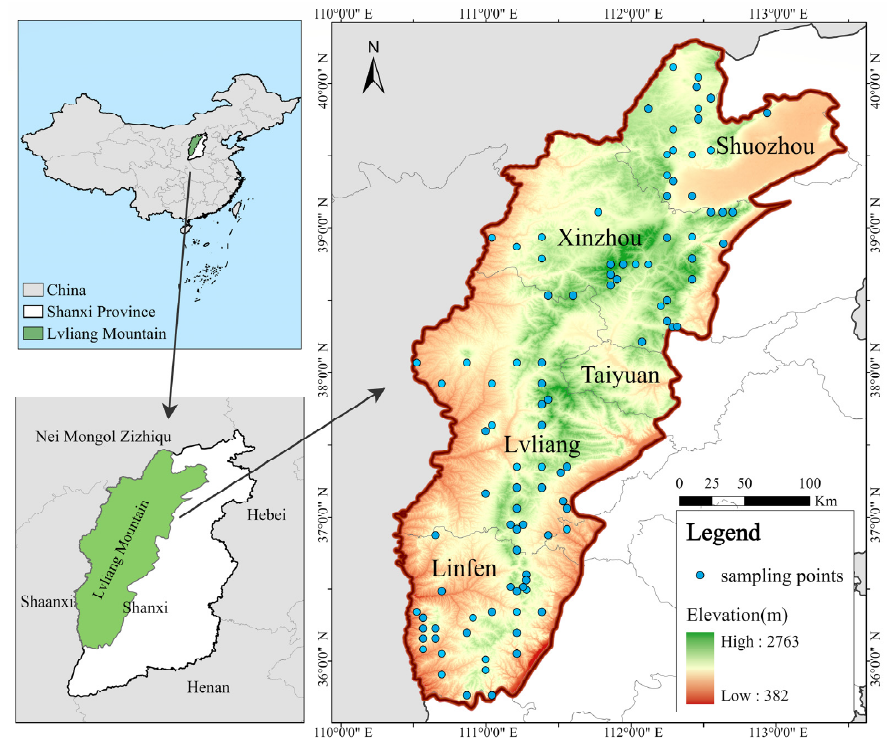
Figure 1. Study area and distribution of sample sites adopted in the Maxent